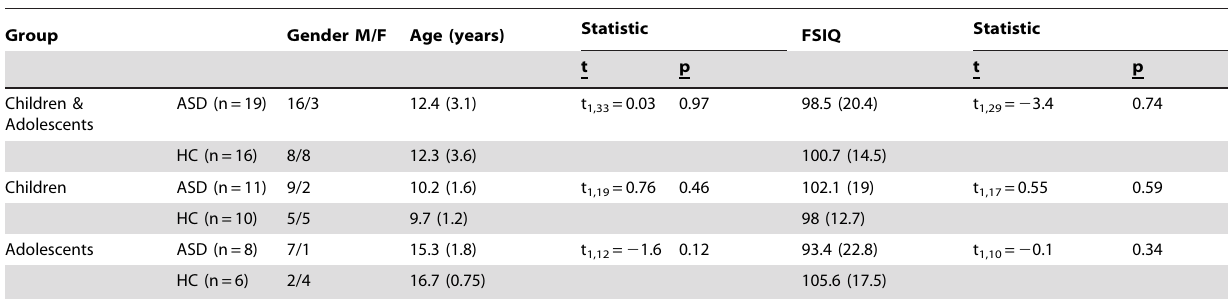
Table 1. Demographic Characteristics.